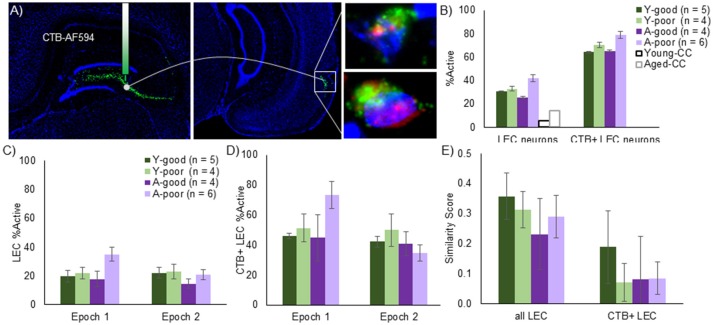
LEC Arc expression in the context of anatomical projections. (A) Mosaic images and schematic of CTB/Arc procedure. The retrograde tracer, CTB, was infused into the CA3 regions and retrogradely transported to cell bodies of LEC neurons that project to this region. Following in situ hybridization, Layer II neurons in the LEC could be identified that are co-labeled with tracer as well as positive for Arc expression. The right panels show representative CTB+ cells with Arc in the nucleus (top) and Arc in both the nucleus and the cytoplasm (bottom). (B) Using this approach, LEC neurons with projections into the CA3 region (CTB+ LEC neurons) can be analyzed relative to the entire LEC population. The % of cells that expressed Arc expression was significantly higher number for the LEC→CA3 projection neurons compared to all layer II LEC neurons and this did not significantly interact with age. When taking each epoch into consideration, however, the proportion of Arc positive neurons were higher in the first epoch for the entire population (C) as well as the LEC→CA3 projection neurons (D). Moreover, the age-poor performing group exhibited a significantly higher % of Arc positive cells in epoch 1 relative to the other groups. (E) Traditional Similarity score for all LEC neurons and LEC→CA3 projection neurons. The LEC→CA3 projection neurons had a significantly lower similarity score across epochs relative to all layer II LEC neurons.